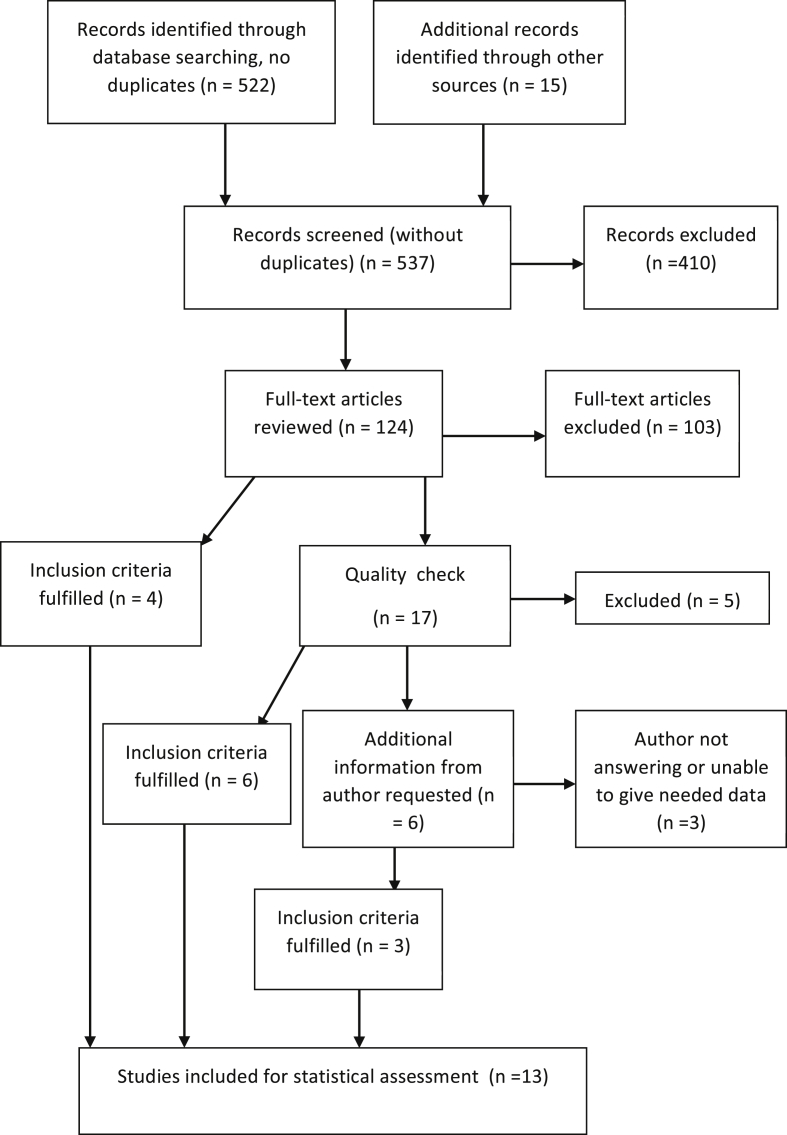
Selection process.